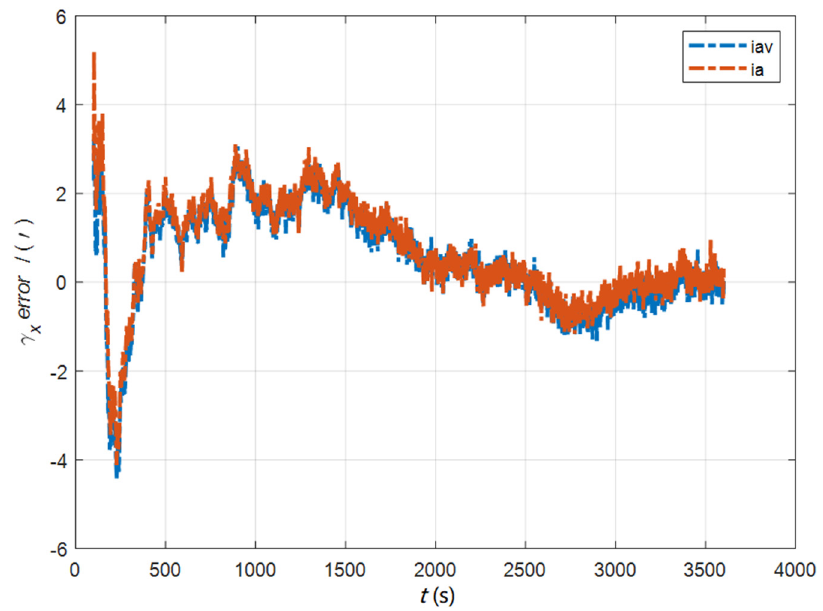
′ [ 0.5 (cid:48) 0.5 (cid:48) 10 (cid:48) ] T . . Figure 16. The error curves of γ x in the cases of the initial misalignment angles